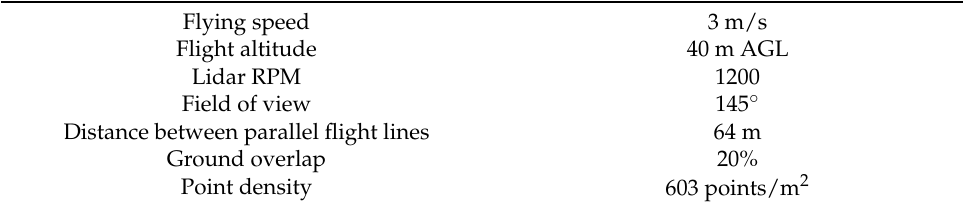
Figure 3. UAV lidar system. Table 2. Flight parameters.